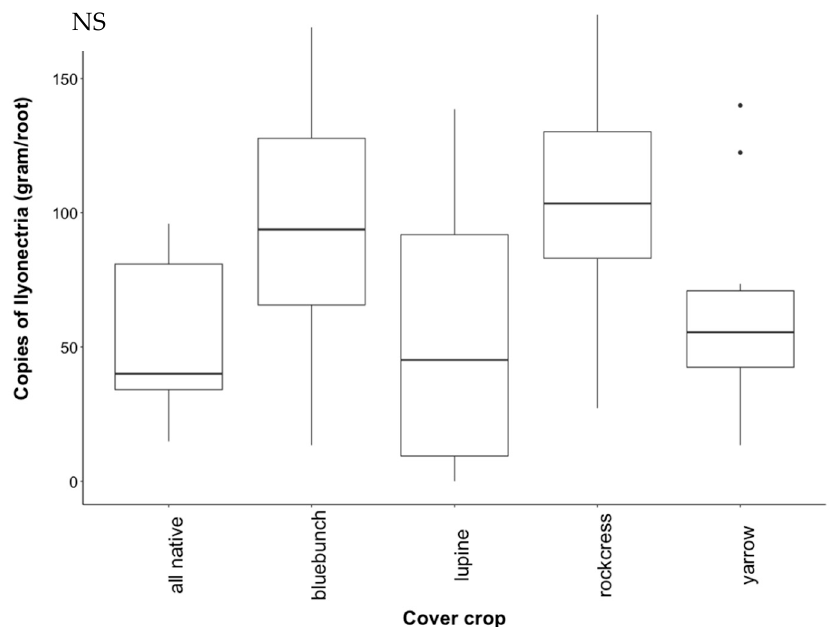
Figure A4 . Recovery of I. liriodendri DNA from native study Chardonnay roots. Treatments are all plants grown together (“all native”), bluebunch wheatgrass (“bluebunch”), silky lupine (“lupine”), Holboell’s rockcress (“rockcress”), and white yarrow (“yarrow”). Data were normalized by taking the square root of the copy number then removing outliers using Tukey’s interquartile range (IQR). Copy number did not differ significantly (NS) between cover crop treatments ( p = 0.109).